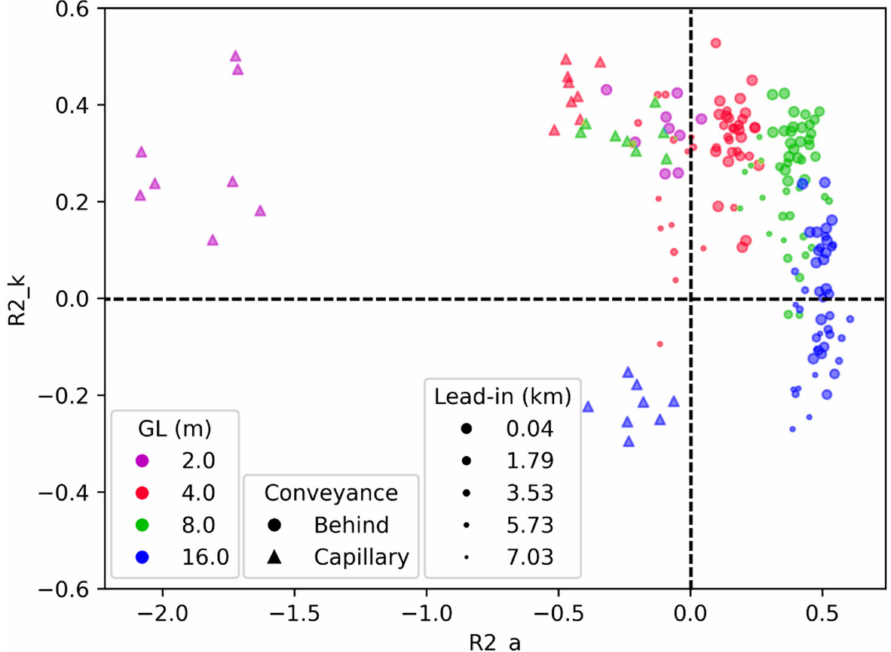
Figure 7. Cross-plot between kinematic (R2_k) and dynamic (R2_a) log-based metrics. Different GL coded by color, type of installation by marker type, and lead-in length by marker size. R2 values less than zero correspond to estimates that are worse than just a constant equal to correct mean values (marked by dashed